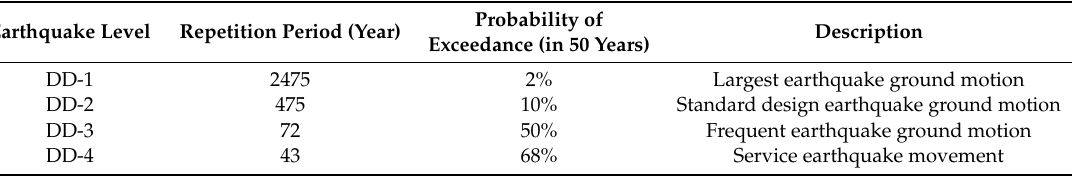
Table 1. Earthquake ground motion levels